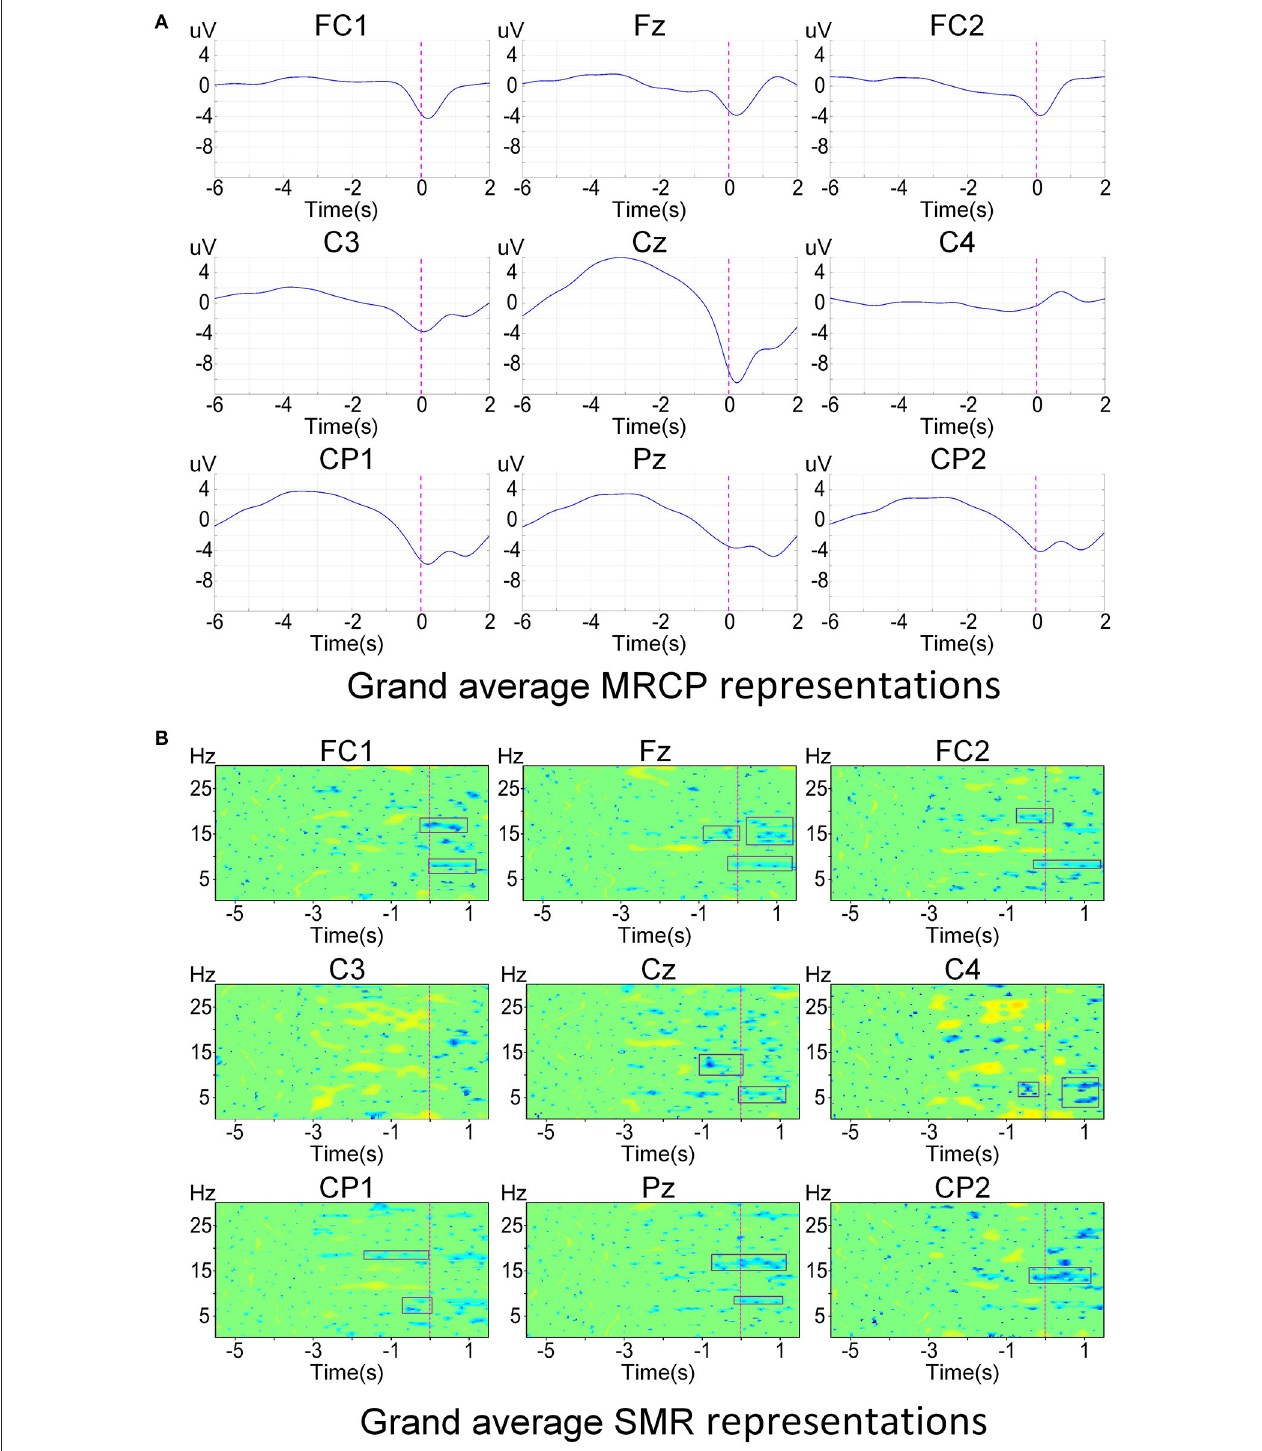
FIGURE 3 | Grand average electrophysiology signals around the motor cortex over all subjects and conditions. The actual movement onset is shown with vertical dashed lines. (A) Grand average time-amplitude representations at [0.1, 1] Hz. (B) Grand average time-frequency representations at [0.1, 30] Hz. Only significant values (bootstrap p < 0.05) are colored and non-significant values are plotted in green.